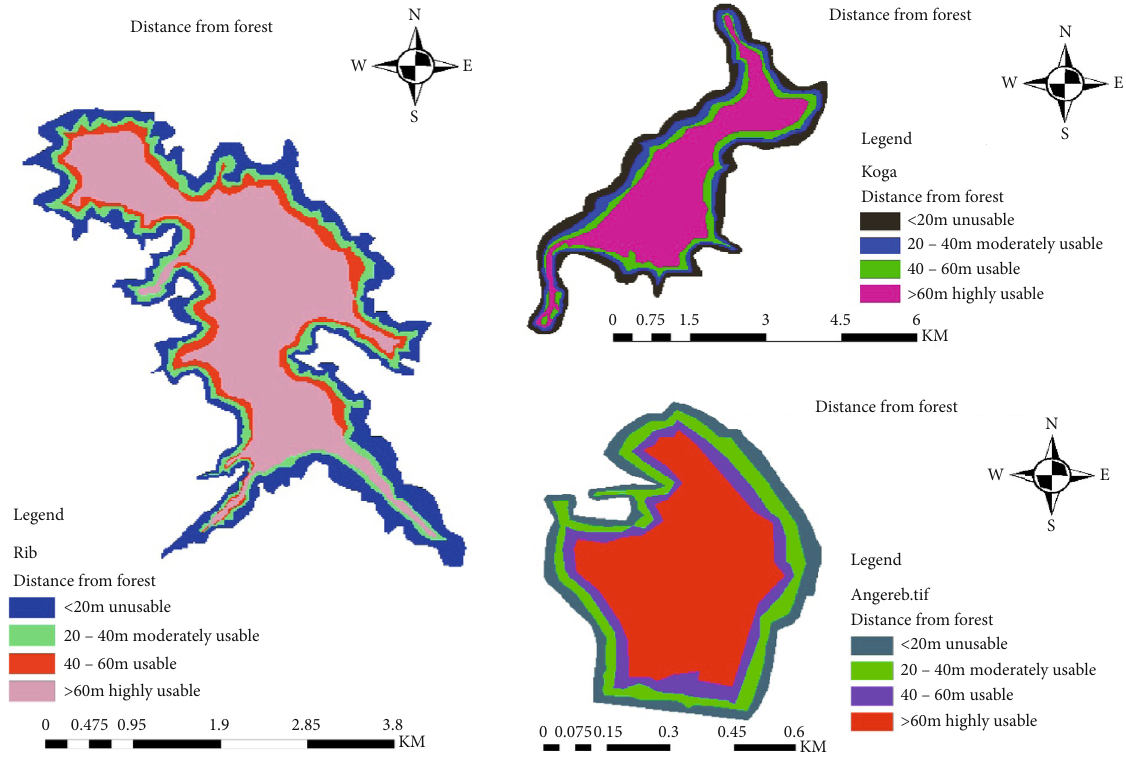
Figure 4: Suitable distance of forest fl oating solar PV.